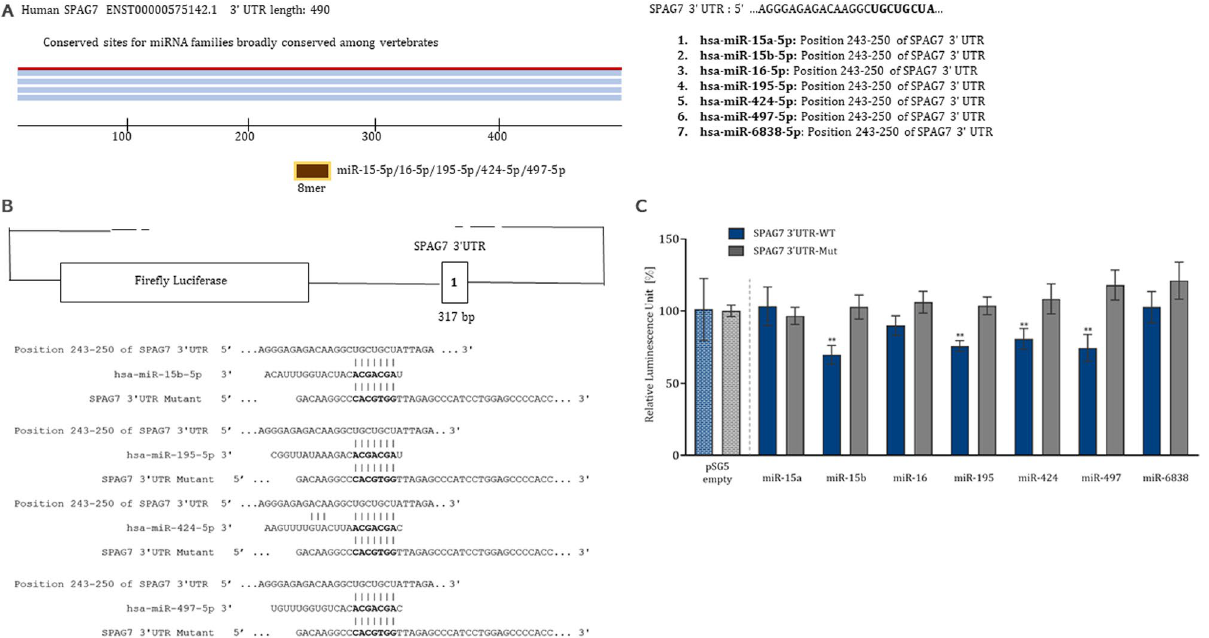
Figure 1. ( A ) Prediction of seven candidate miRNAs potentially binding to the SPAG7 3’-UTR, ( B ) Schematic diagram of the location of the predicted binding sites of miRNAs within the SPAG7 3’UTR region. The sequences of the binding sites of miR-15b, miR-195, miR-424, and miR-497 and the mutated binding sites (bold letters) are shown, ( C ) Dual luciferase assays of the 3’UTRs of SPAG7 and seven tested miRNAs. The results represent the mean of at least three independent experiments carried out in duplicates. Student’s t-tests and mean ± SEM were used to evaluate differences in expression level. P < .05 was considered statistically significant (* P < 0.05; ** P < 0.01; *** P <